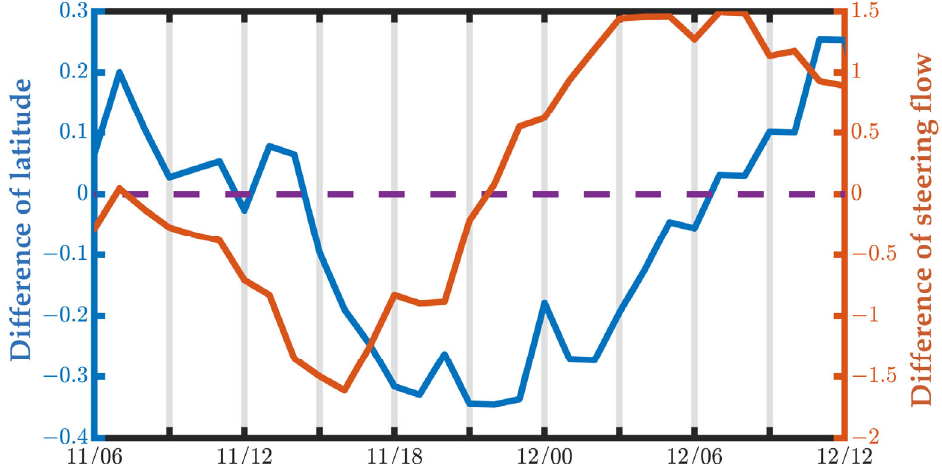
Figure 7. The differences of the central latitude of Songda (dark blue lines; degree) and meridional steering flow (orange lines; m s (cid:2879)(cid:2869) ) between the control and SST4.5. The steering flow is defined as the horizontal wind vertically averaged below 200 hPa with mass weighting after taking the horizontal average within a 500 km radius from the cyclone center (c.f. the definition in [42]). The dotted purple line is the zero reference line. The D2 output is utilized.